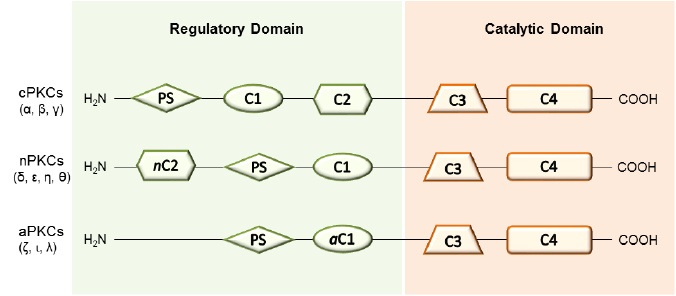
Figure 1. General structure of PKCs.